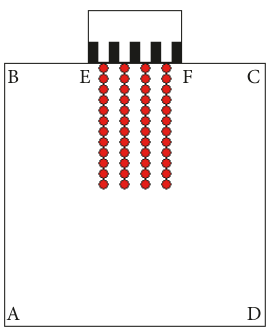
Figure 5: The sketch of passengers’ boarding at the hall of an HSR station.